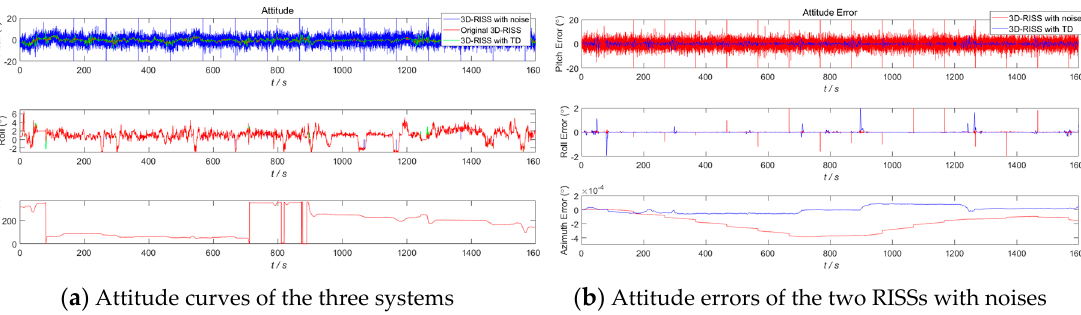
Figure 9. RISS attitude and attitude errors with a noisy odometer velocity filtered by TD.